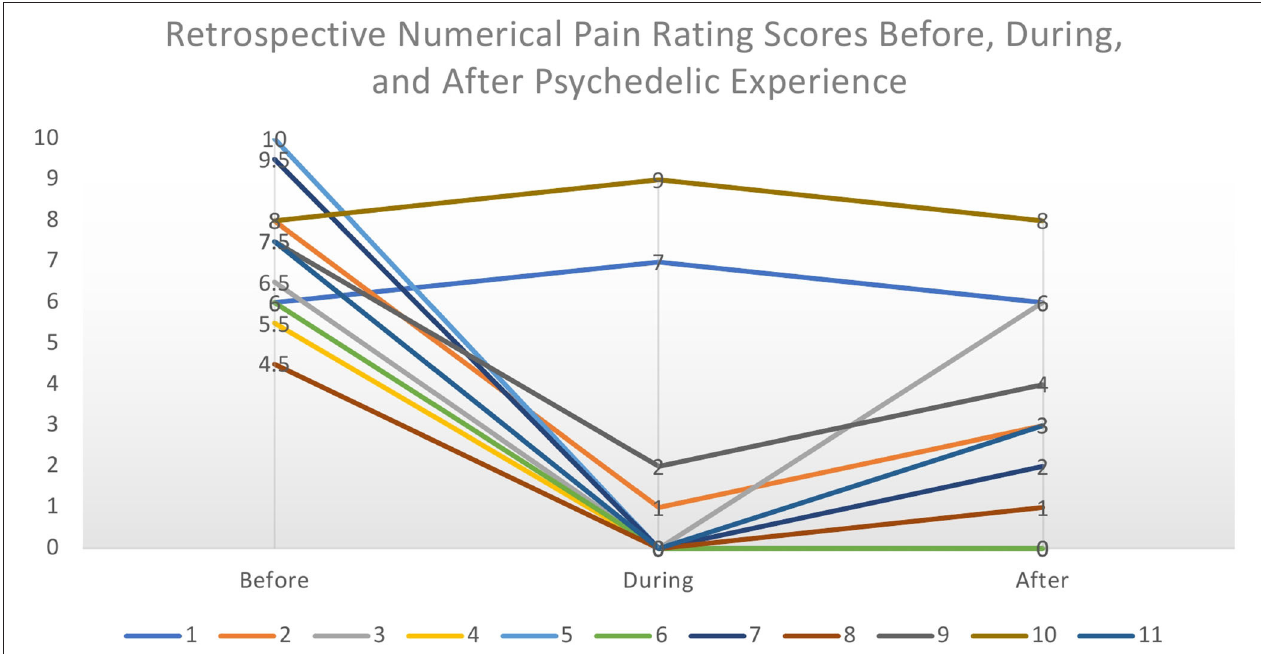
FIGURE 2 | Retrospective Numerical Pain Rating Scores from each contributor before, during, and after the psychedelic experience. The perceived intensity of pain was considerably lowered during the acute psychedelic state and slowly increased to the normal level over a period of hours to days. We make no inferences on causality from these retrospective subjective